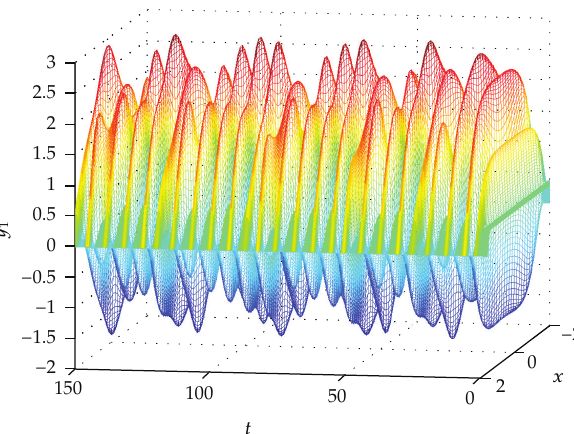
Figure 1: Chaotic behavior of the state y 1 (cid:6) t,x (cid:7) in system (cid:6) 4.1 (cid:7) .